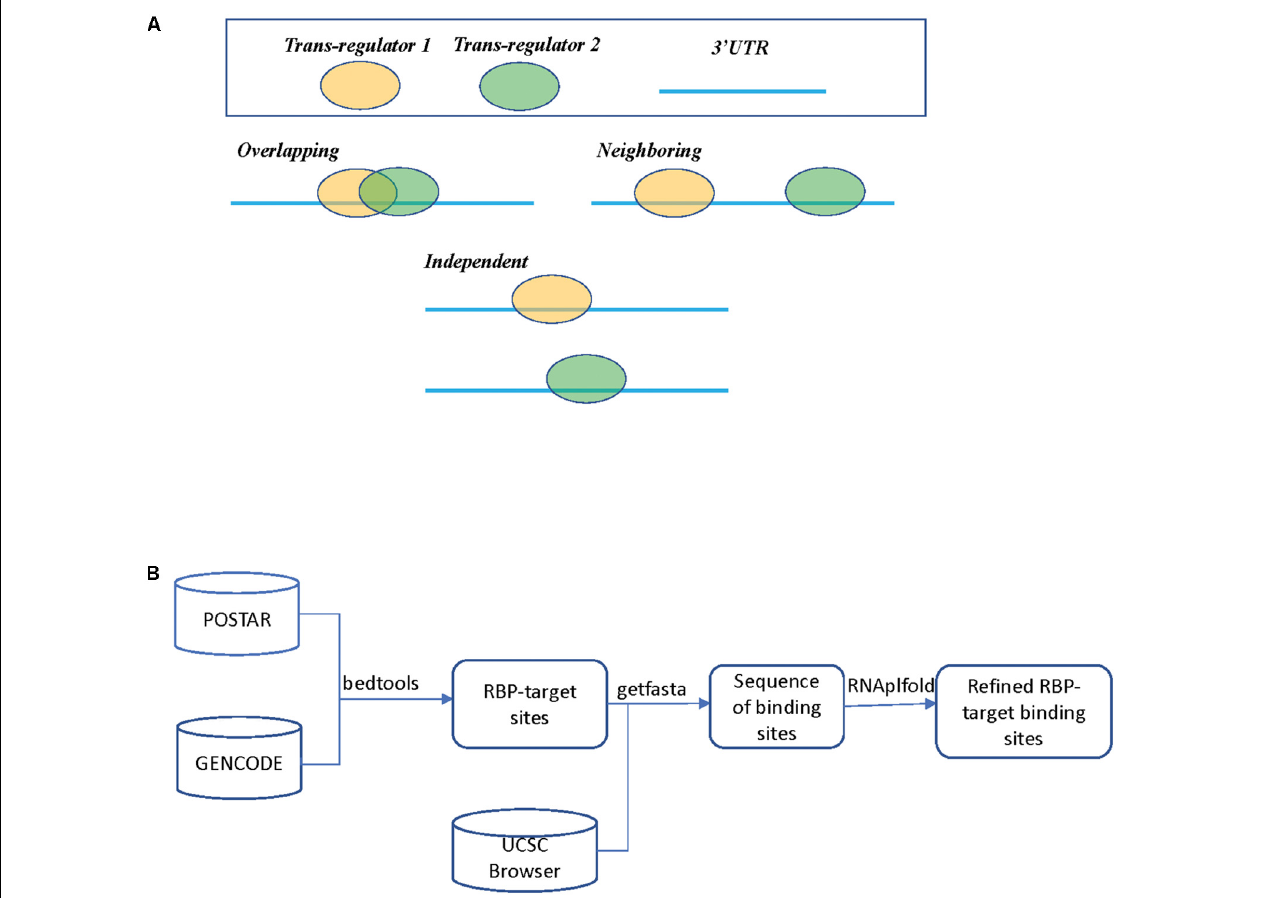
FIGURE 1 | (A) Three different scenarios between two trans regulators. In scenario 1 ( Overlapping ), both trans regulators target the same mRNA transcript with overlapping binding sites. In scenario 2 ( Neighboring ), both trans regulators target the same mRNA transcripts but the binding sites do not overlap. In scenario 3 ( Independent ), the two trans regulators do not bind to the same transcript. (B) A flowchart on determining RBP binding sites.